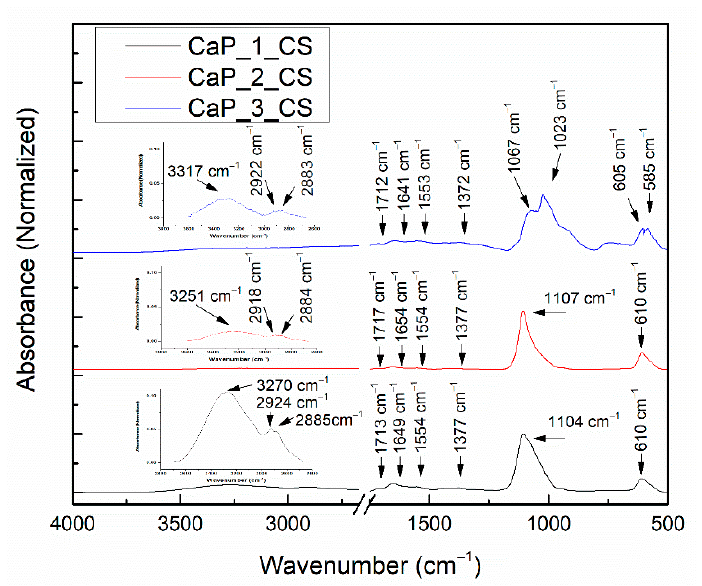
Figure 11. FTIR spectra of CaP_CS layers.